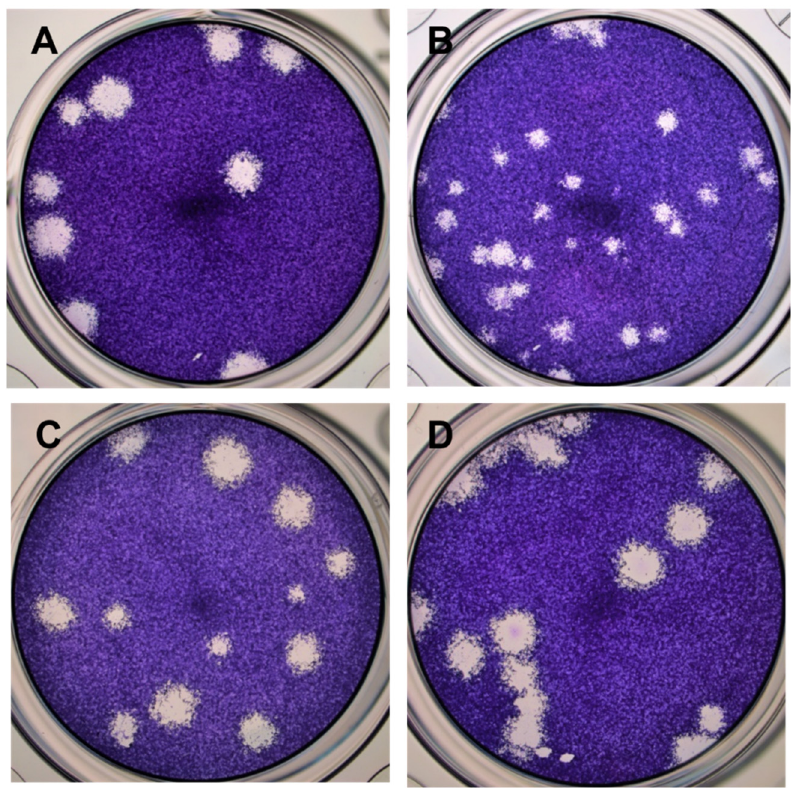
Figure 2. Plaque morphology of various GETV strains in Vero cells. Plaques shown were at 72 hpi; ( A ) GI GETV MM2021, ( B ) GIV GETV B254, ( C ) GIII GETV MI-110, ( D ) GIII GETV 14-I-605 (5× mag- nification).